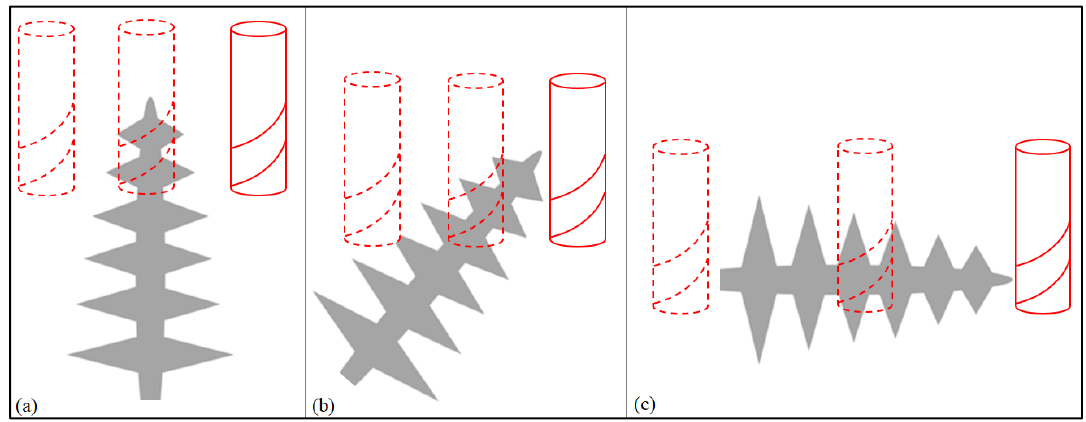
Figure 12. Machining Steps Representation ( a ) 0 degrees, ( b ) 35 degrees, ( c ) 90 degrees.